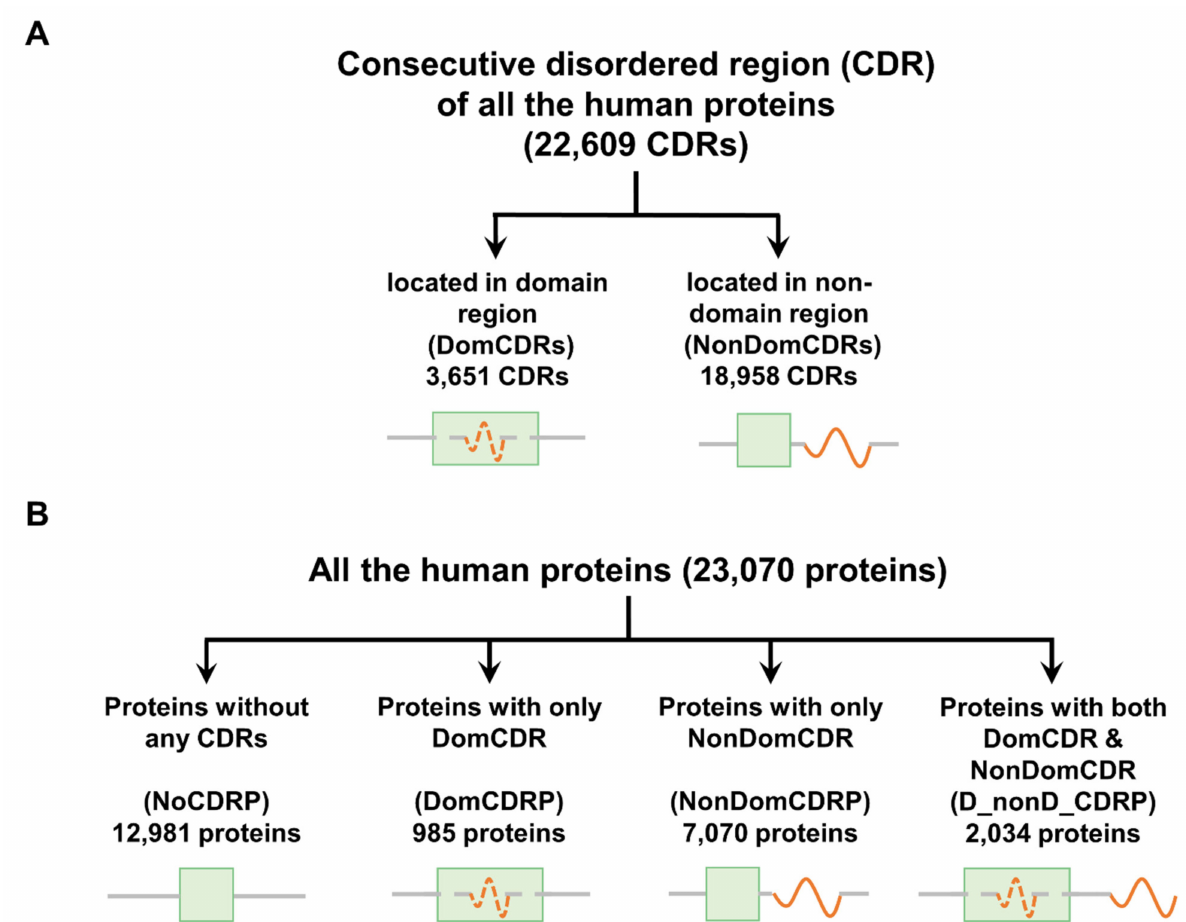
Figure 1. Schematic representation of the classifications of consecutive disordered region (CDR) and all the proteins. Human CDRs and proteins are used as the example in this figure. Two types of CDR were classified based on their locations relative to protein domains ( A ). Four types of proteins were classified based on the CDR types in the protein ( B ). The boxes represent the protein domains. The red dash or solid curve lines represent the CDRs inside or outside protein domains,